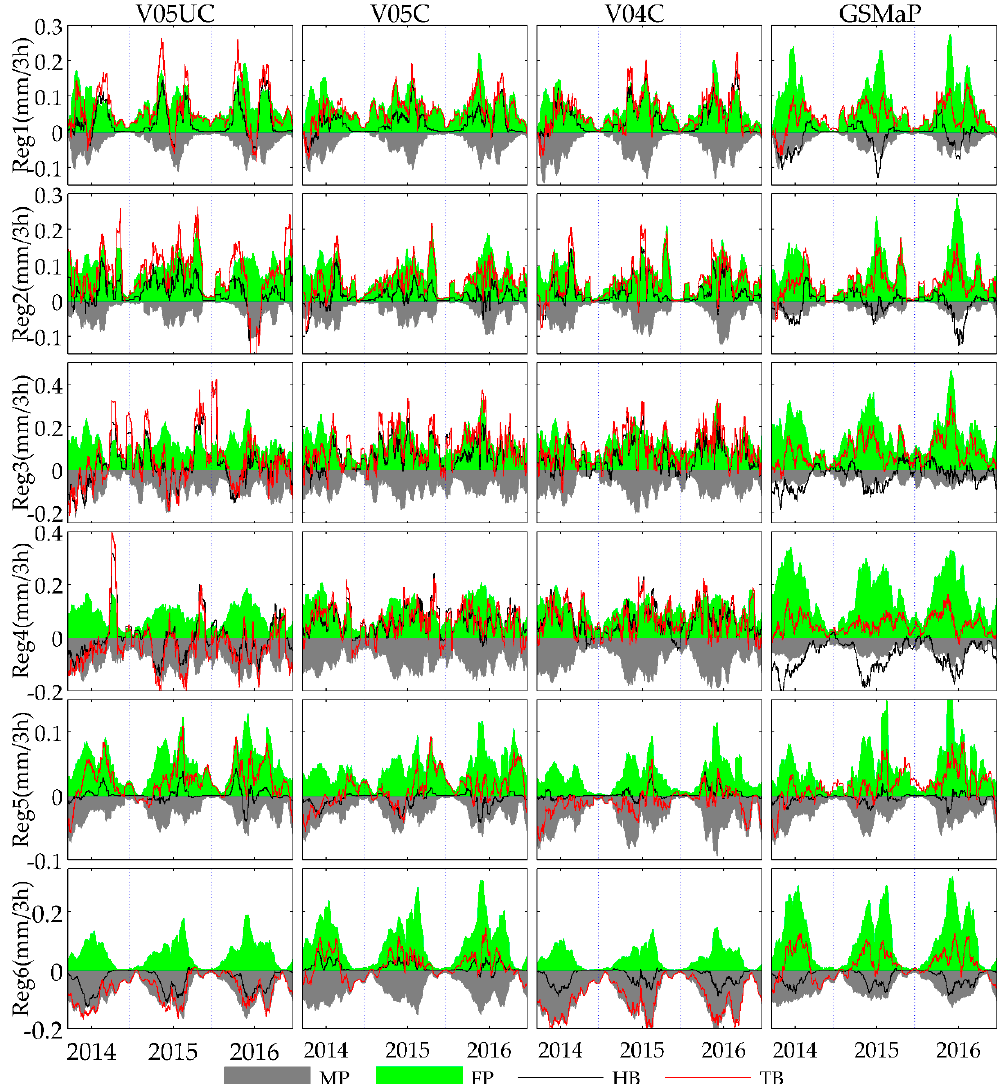
Figure 9. Regionally averaged time series of error components and total bias for four GSPEs (i.e., V05UC, U05C, V04C, and GSMaP) at a 3-h resolution.